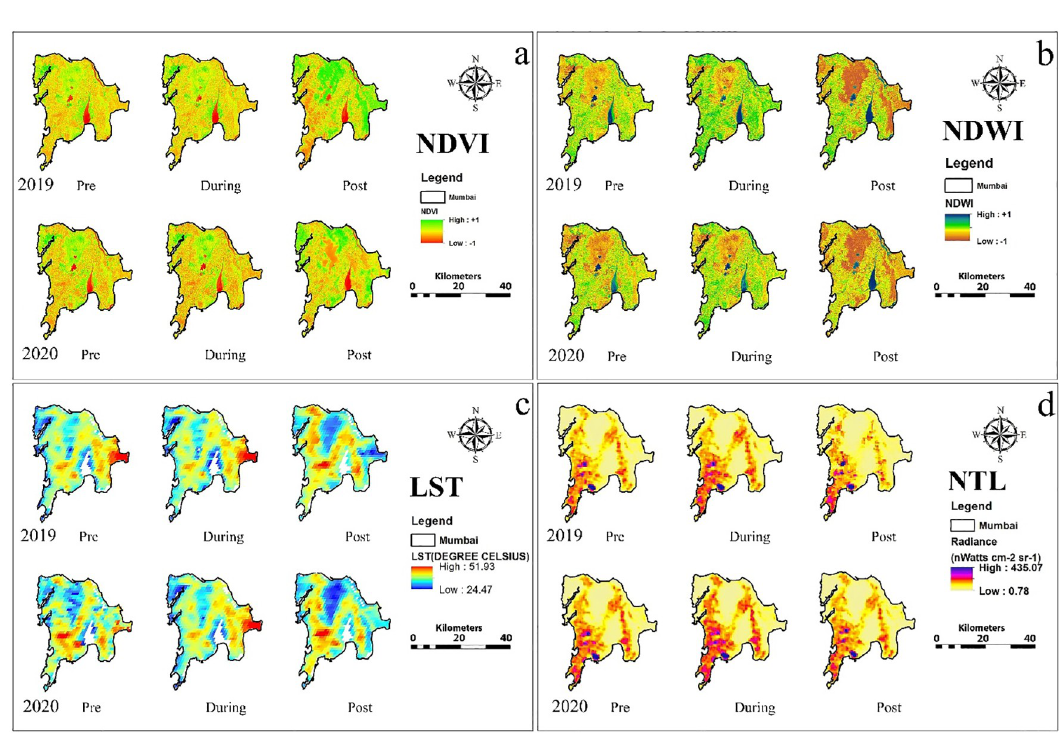
Fig 3. Spatio-temporal changes in a) NDVI, b) NDWI, c) LST and d) NTL based on the thematic maps of the Mumbai city.